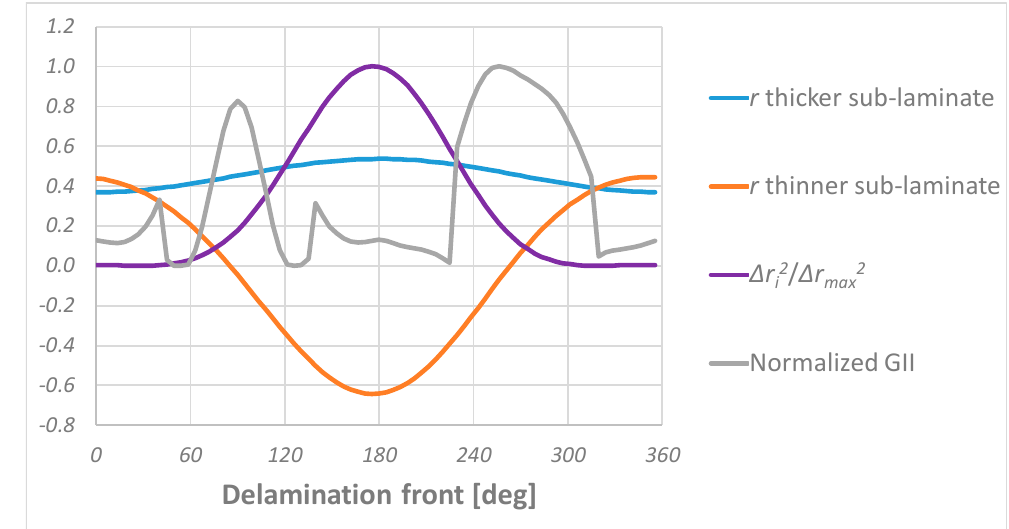
Figure 19. Radial displacement field from non-linear analysis.